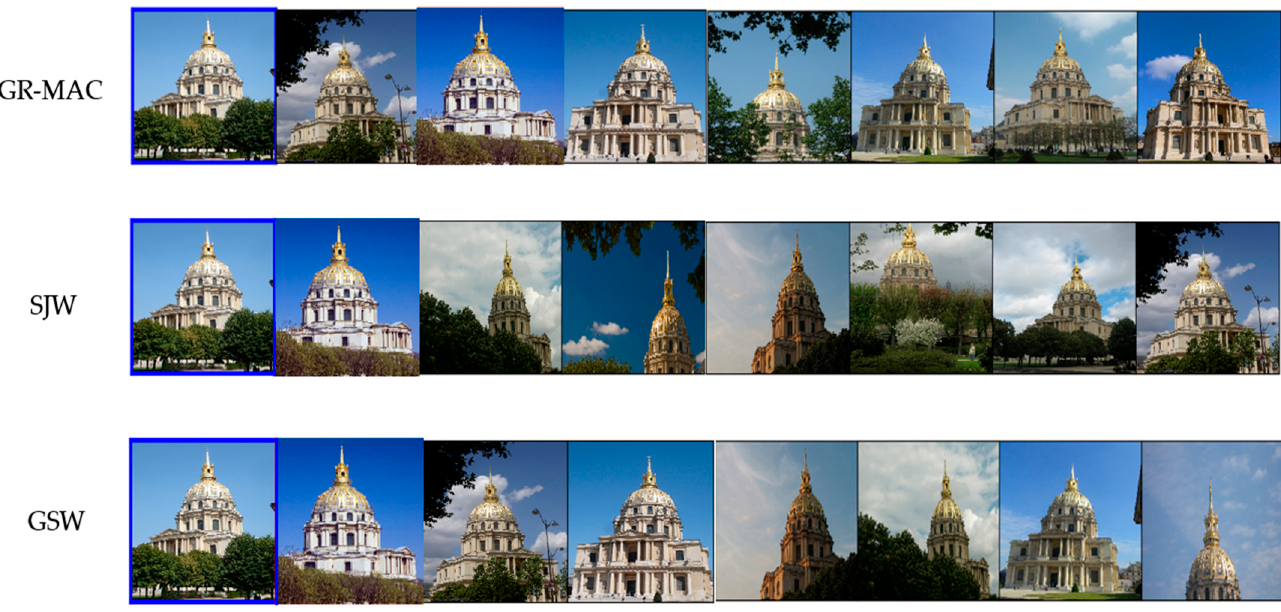
Figure 7. Top seven retrieval results for the Paris data set.